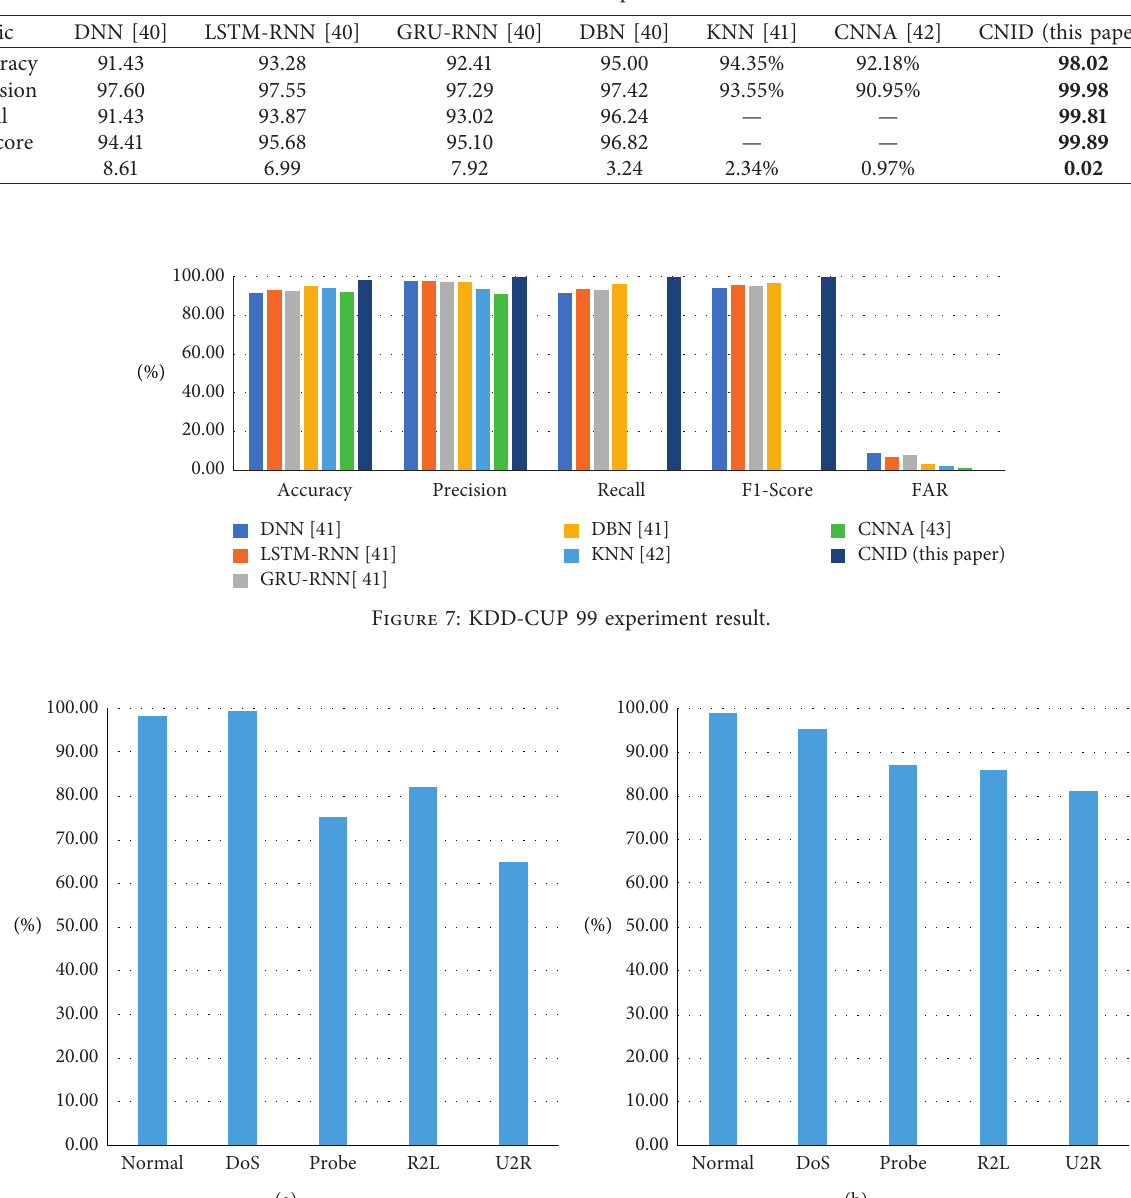
Table 4: KDD-CUP 99 experiment result.